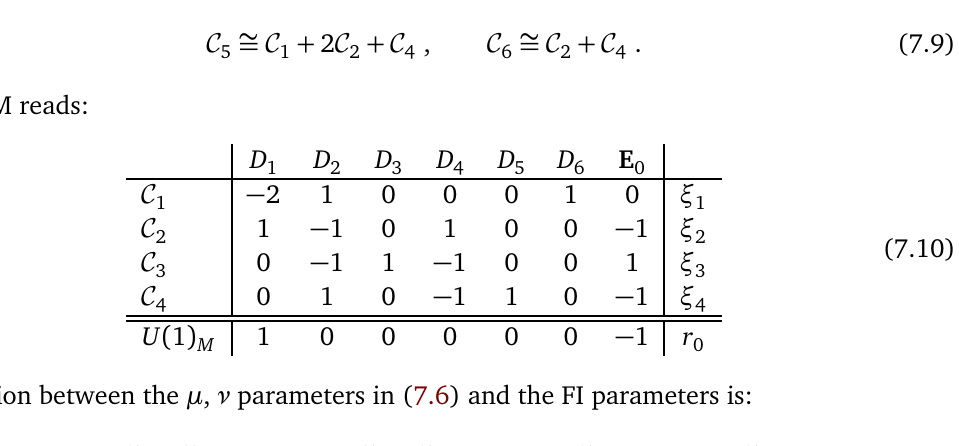
Figure 31: IIA profile for the resolution “(c)” of the E